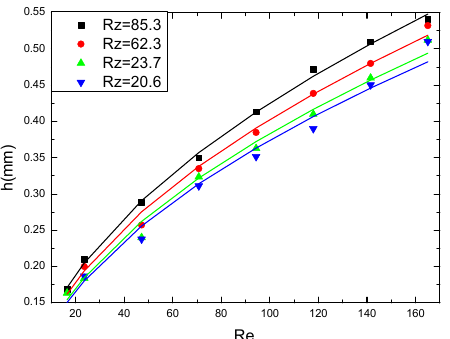
Figure 7. Comparison of average thickness of water film under different roughness.